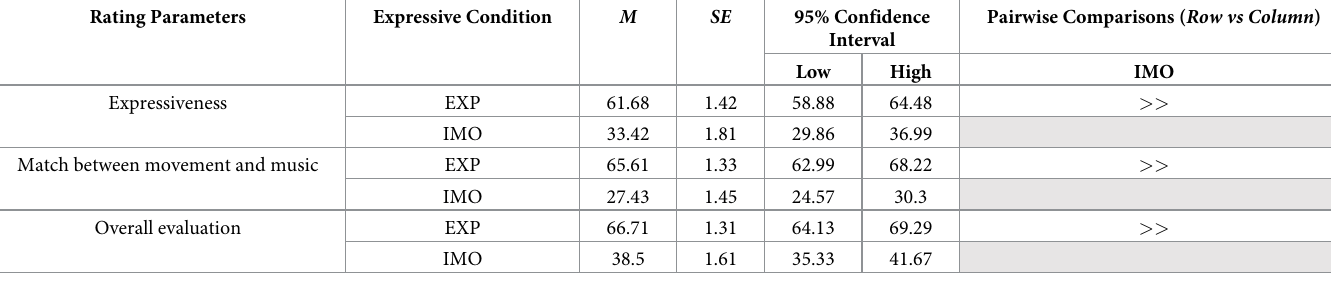
Table 2. Descriptive statistics and pairwise comparisons of each dependent variable across expressive conditions. Rating